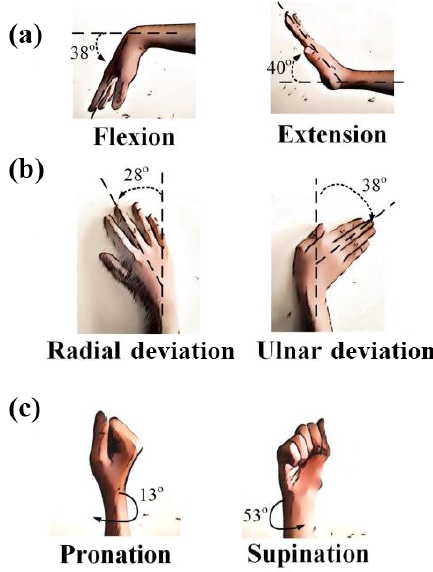
Figure 1. Wrist and forearm movement: (a) flexion–extension represents pitch; (b) radial–ulnar deviation represents yaw, and (c) pronation–supination represents roll. The angle value is the nor- mal value based on the previous study.